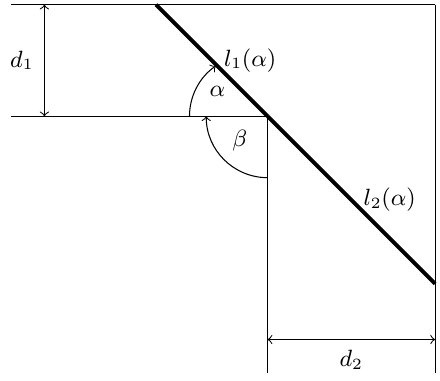
Figure 1. Schematic diagram of the